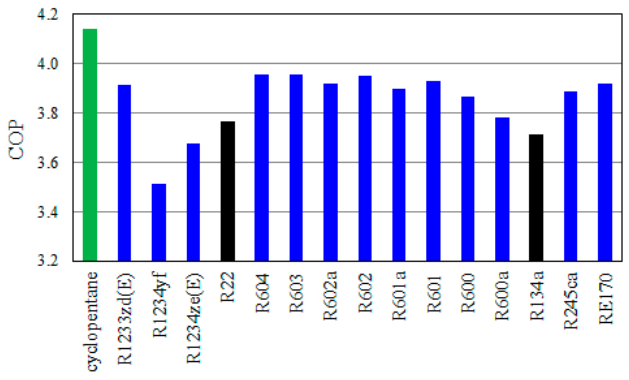
Figure 4. The COP of VCRC using pure refrigerants.